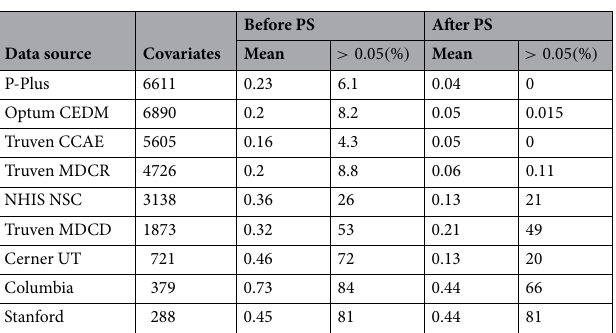
Table 3. Number of covariates by data source, along with mean standardized differences and percentage with standardized difference greater than 0.05 before and after propensity score(PS) adjustment.